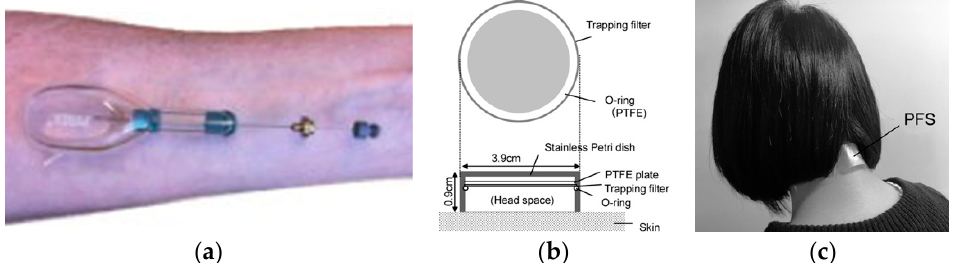
Figure 3. ( a ) Headspace sampling volatiles on the volar forearm using a wearable housing integrating solid phase microextraction (SPME) fiber, affixed to the skin with surgical tape. ( b ) Schematic view of the passive flux sampler for human skin gas. ( c ) Sampling of 2-nonenal and diacetyl at the nape of the neck. The PFS (passive flux sampler) was fixed by a piece of medical tape. Reproduced from [63,73], with permission from Wiley and Elsevier, 2019.